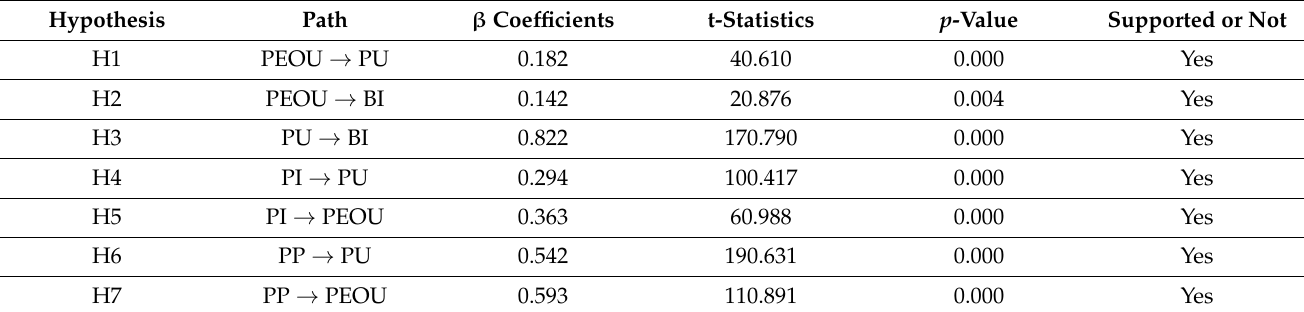
Table 7. Structural model’s results.